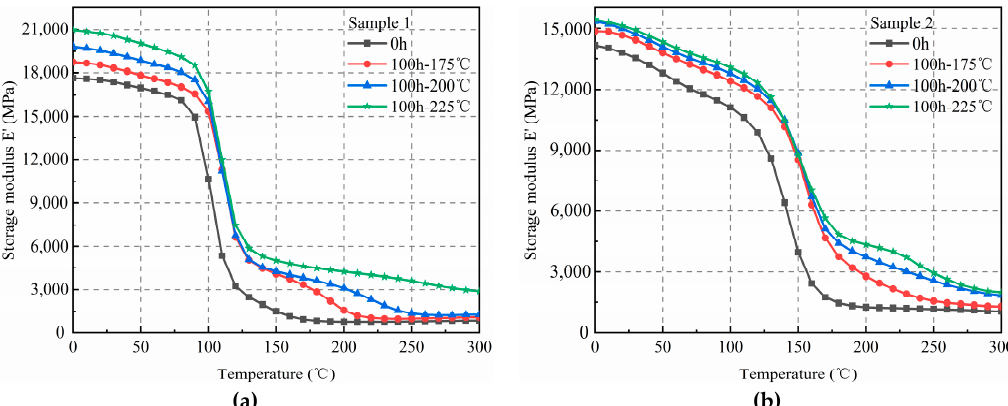
Figure 2. Elasticity modulus of EMC(Epoxy Molding Compound) after 100 hr of aging at three different temperatures. ( a ) Sample 1; ( b ) Sample 2.